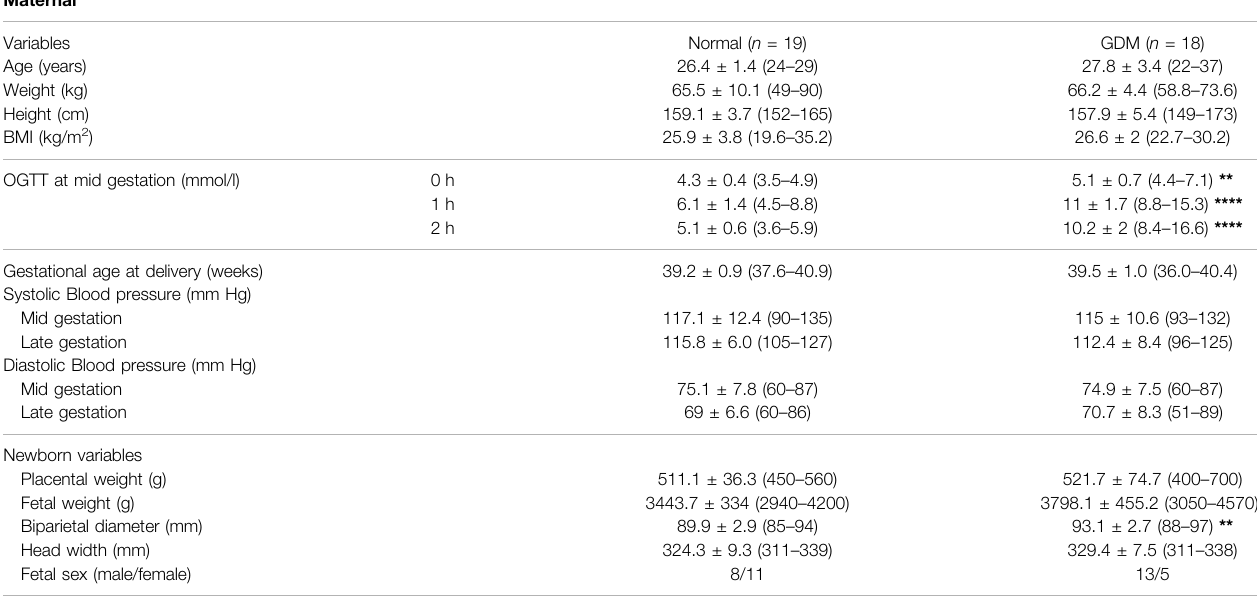
TABLE 1 | Demographic characteristic of GDM and normal pregnant women. Maternal